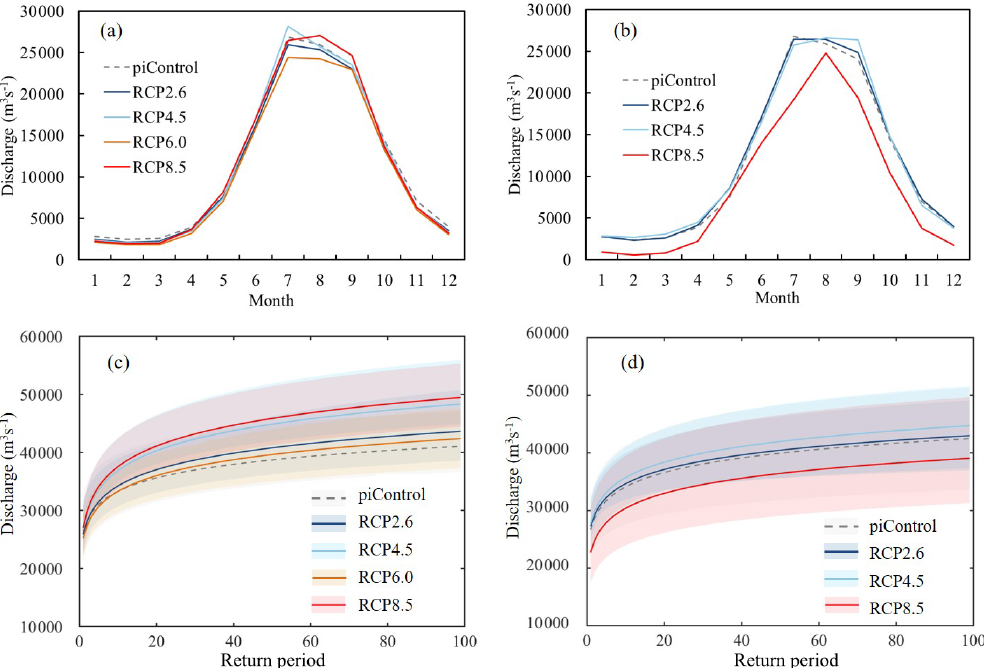
Figure 10. Comparison of monthly mean simulated discharge and return periods of daily maximum discharge at the Cuntan station for 2070–2099 (a, c) and 2270–2299 (b, d) under RCPs and the piControl